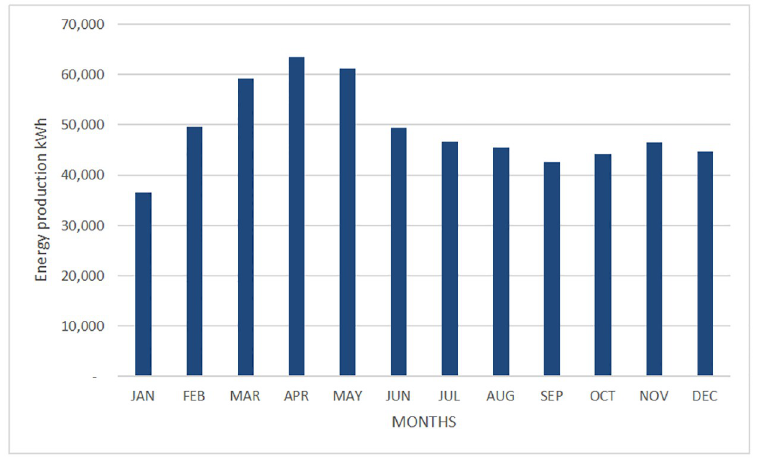
Fig 3. Monthly energy generated by the PV system in Cuernavaca city.